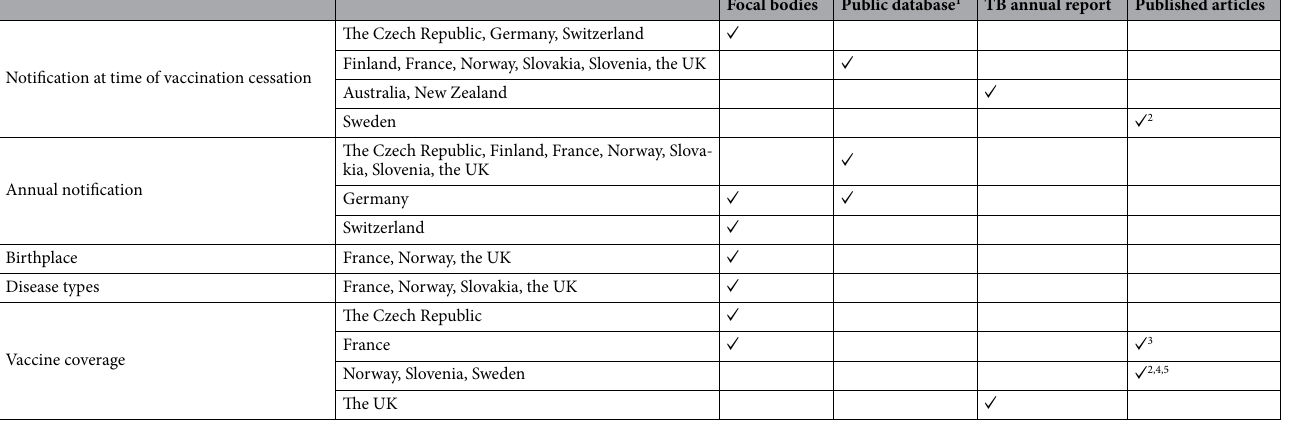
Table 1. Sources of data. 1 Surveillance and disease data. European Centre for Disease Prevention and Control (https:// www. ecdc. europa. eu/ en/ surve illan ce- and- disea se- data). 2 Romanus, V., Svensson, A. & Hallander, H. O. The impact of changing BCG coverage on tuberculosis incidence in Swedish-born children between 1969 and 1989. Tuber. Lung Dis. 73 , 150–161 (1992) (Sweden). 3 Guthmann, J. P., Antoine, D., Fonteneau, L., Che, D. & Lévy-Bruhl, D. Assessing BCG vaccination coverage and incidence of paediatric tuberculosis following two major changes in BCG vaccination policy in France. Euro. Surveill. 16 , 19,824 (2011) (France). 4 Evaluering og revisjon av råd om BCG-vaksinasjon gjeldende fra 1. juni 2018 [Evaluation and revision of advice on BCG vaccination valid from 1 June 2018]. Folkehelseinstituttet [Norwegian National Institute of Public Health] (2018). Feiring, B. et al. Do selective immunisation against tuberculosis and hepatitis B reach the targeted populations? A nationwide register-based study evaluating the recommendations in the Norwegian Childhood Immunisation Programme. Vaccine. 34 , 2015–2020 (2016) (Norway). 5 Infoso, A. & Falzon, D. European Survey of BCG Vaccination Policies and Surveillance in Children, 2005. Euro Surveill. 11 , 6–11 (2006)